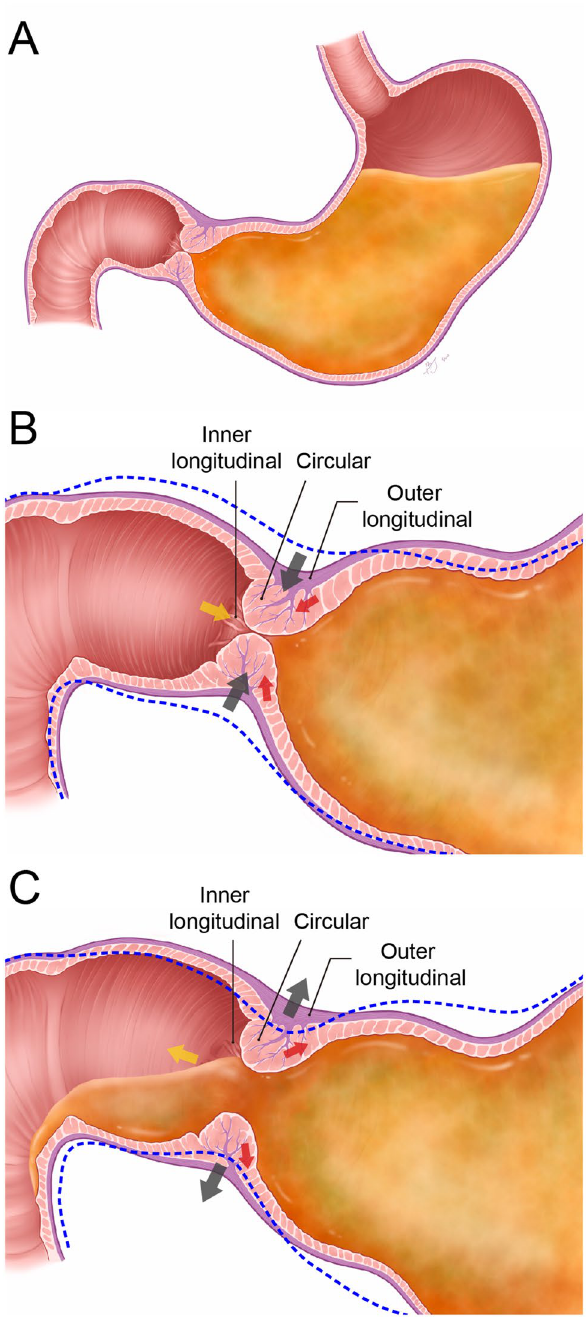
Figure 9. Potential steps in the contraction of the three pyloric sphincter (PS) layers. ( A ) In the early stage of the simulation, gastric contents are passing toward the PS. ( B ) As simulation continues, the three PS layers contract. Contractions of the inner (yellow arrow) and outer (red arrow) longitudinal bundles may simultaneously improve the balance between the outer and inner walls of the PS during local longitudinal shortening, enhancing PS motility and tightly closing the lumen. Contraction of the middle circular bundles (black arrow) may close the pyloric lumen. Contractions of the three PS layers may induce contraction of the oral duodenum toward the PS, combining these structures to improve length and intraluminal resistance to control the passing of gastric contents into the duodenum. ( C ) The PS then relaxes back to its original diameter and the oral duodenum moves backward, relaxing back to its original position. Blue dashed lines indicate the former PS shape and its adjacent PC and duodenum before the motility